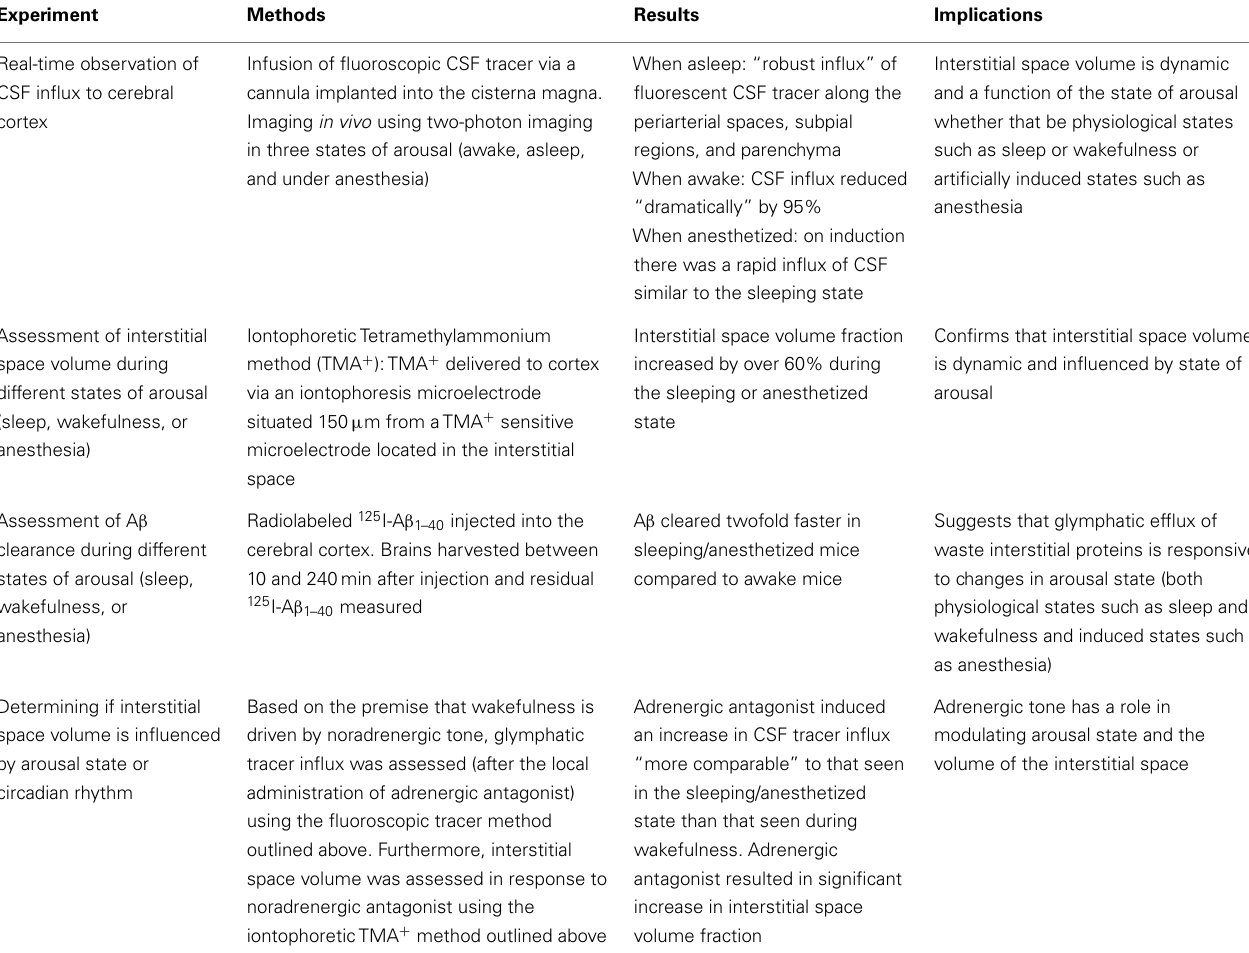
Table 1 | Summary of four principal experimental methodologies, results, and